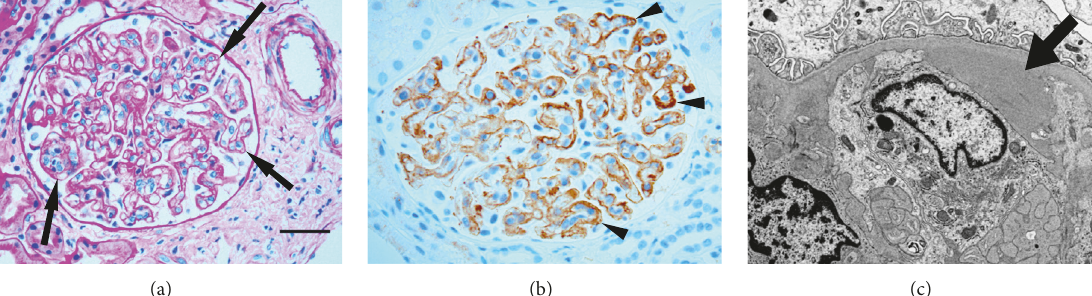
Figure 1: Some key renal biopsy findings. (a) PAS-stained section showed (arrows) duplication of glomerular basement membranes and endotheliosis (PAS stain; bar = 50 𝜇 m). (b) Immunohistochemical stain demonstrated C4d deposition within glomerular capillaries (highlighted by arrowheads). (c) Electron microscopy demonstrated conspicuous subendothelial electron dense deposit (arrow).